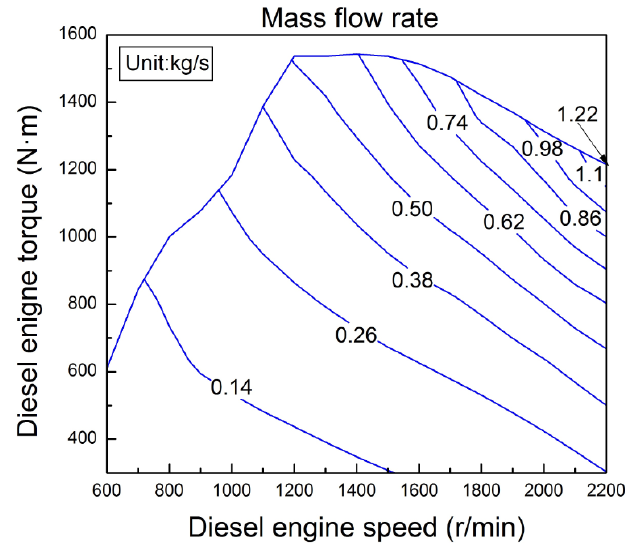
Figure 11. Mass flow rate of the working fluid